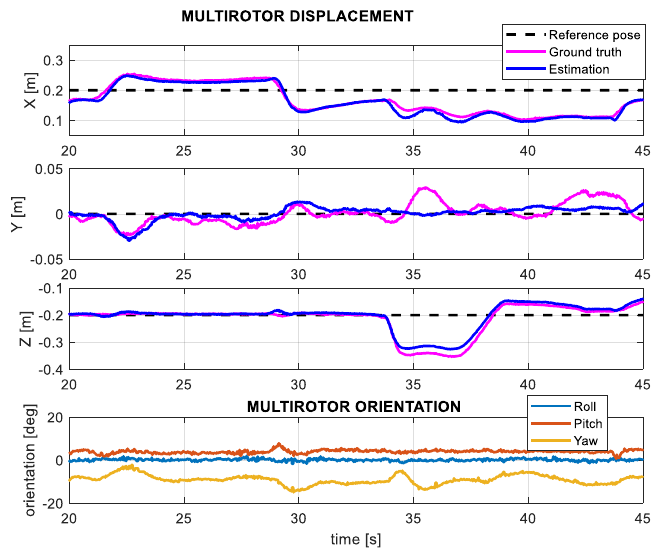
Figure 8 . Multirotor displacement in the grabbing maneuver with zero torque control. Nominal pose (black), displacement measured by OptiTrack (magenta), and arm estimation (blue).